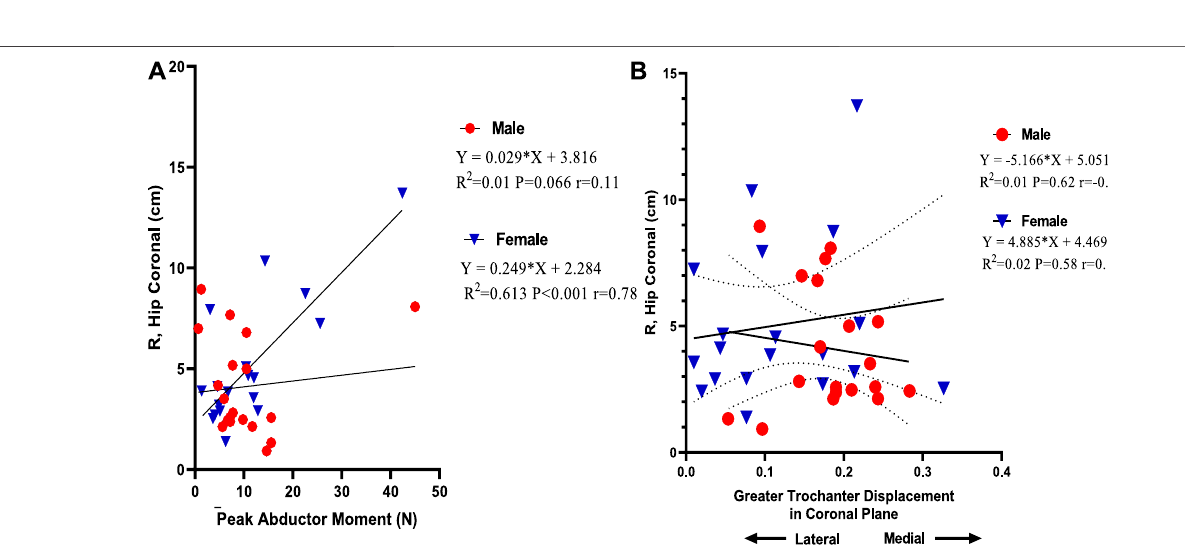
FIGURE8|(A) Linearregressionofpeakabductormomentversusgroundreactionforcemomentarm,R. (B) Linearregressionofgreatertrochanterdisplacement versus ground reaction force moment arm,